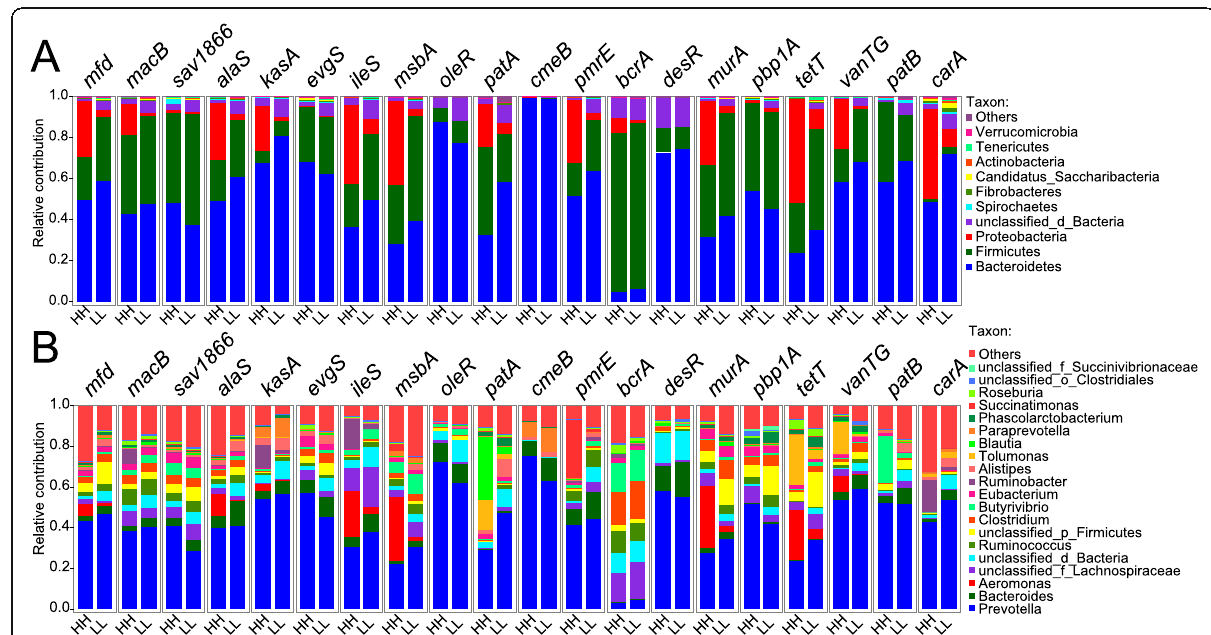
Fig. 5 Distributions of ARGs annotated to bacterial taxa in the rumen of cows with different milk protein yield. The proportion of ARG contigs annotated to the top 10 most abundant bacterial phyla ( a ) and top 20 most abundant bacterial genera ( b ) are shown in the bar plots. ARGs: antimicrobial resistance